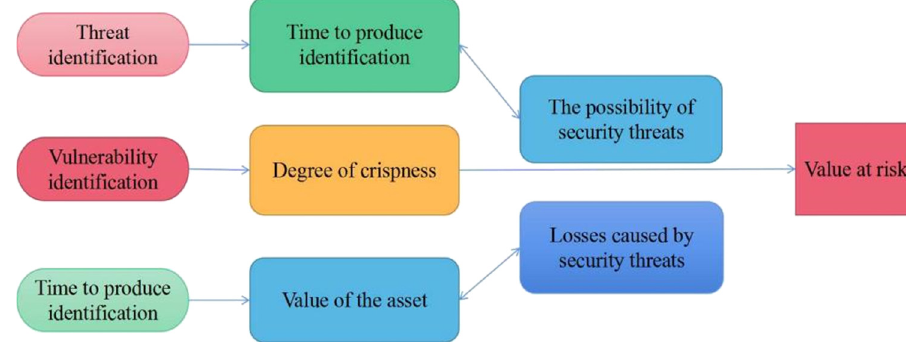
Figure 2: Network security risk